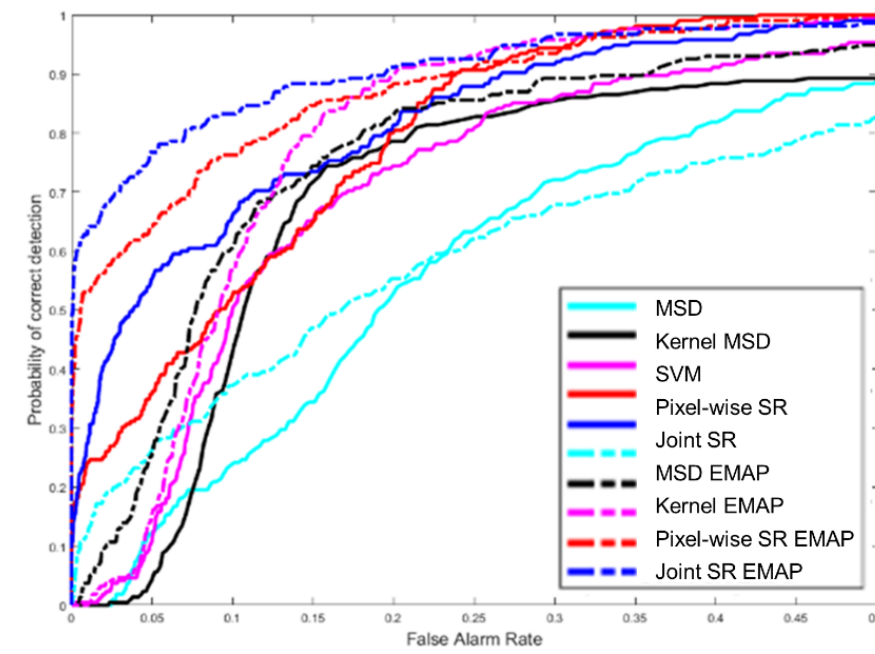
Figure 10. Soil detection results using synthetic bands.